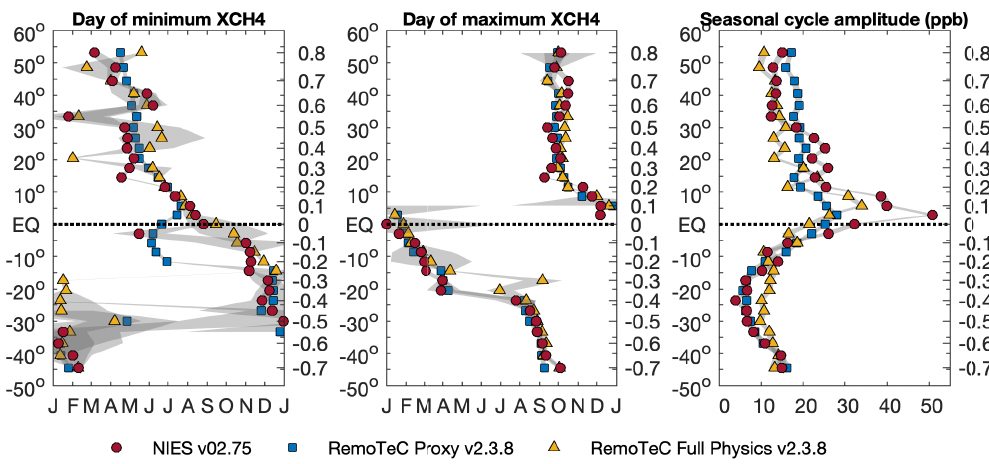
Figure 12. Latitudinal dependence of the minimum day, the maximum day, and the XCH 4 seasonal cycle peak-to-peak amplitude for all three GOSAT XCH 4 retrievals studied. Shaded areas show the calculated uncertainty ranges for the studied variables (for uncertainty ranges see Section 3.3 and Appendix